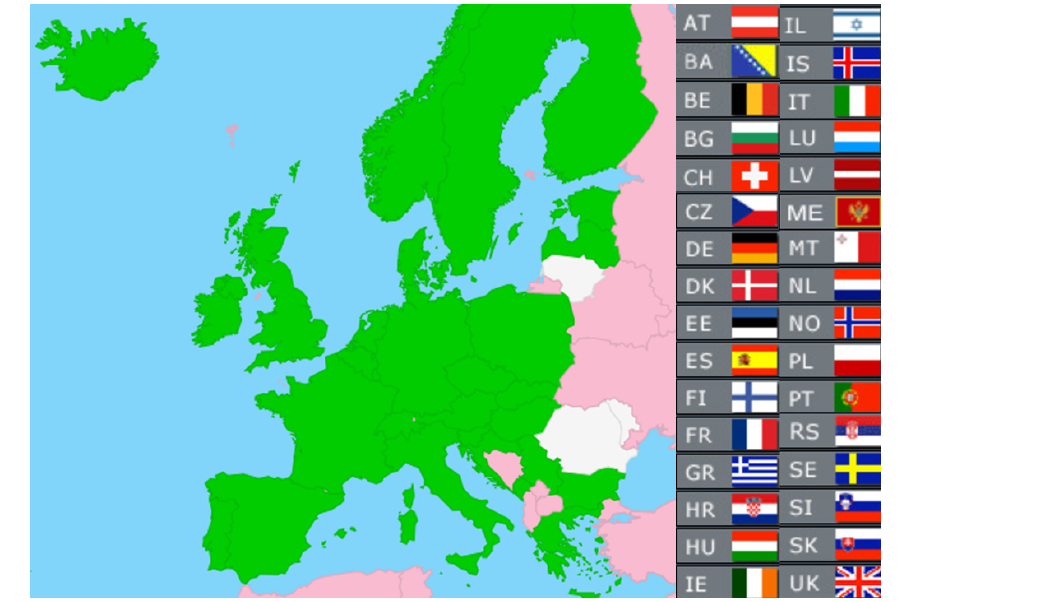
Figure 2. 32 (marked in green) of 37 (86%) NMHSs, participating in the EUMETNET EMMA/Meteoalarm project, responded to 79 ques- tions within a survey on impact-oriented and impact-based warnings, carried out from August 2018 to May